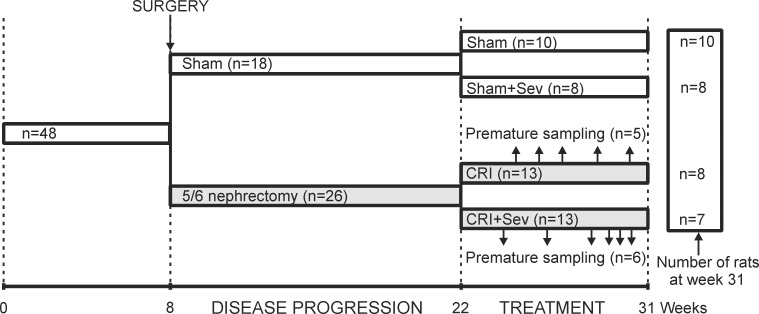
The flowchart of the study.Sham, group subjected to renal decapsulation; CRI, chronic renal insufficiency group subjected to 5/6 nephrectomy; Sev, 3.0% sevelamer-HCl in chow. Four rats were euthanized because of deteriorated general condition during the immediate postoperative period. Small arrows during the treatment period denote premature sampling of individual rats due to deteriorated physical state (see Methods).